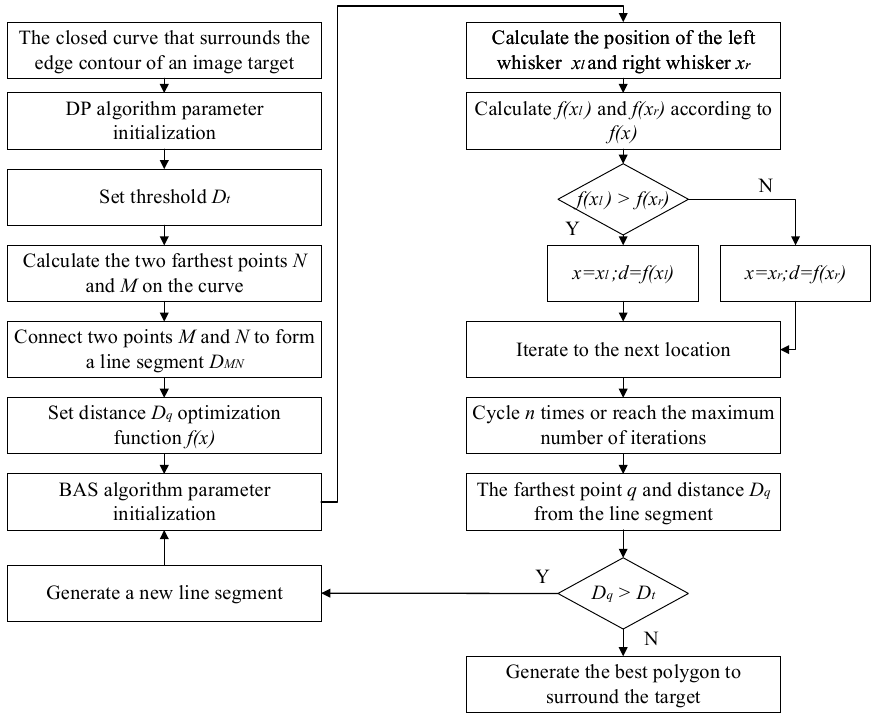
Figure 7. The calculation steps of BAS-DP lightweight contour extraction algorithm.